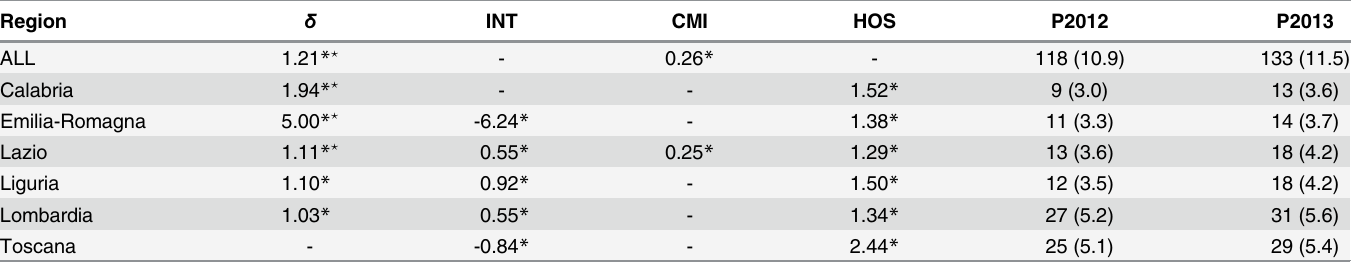
Table 11. Estimates and predicted claims due to injuries at birth. The asterisk indicates significance at 5% level, the star ? indicates that δ is also signifi- cantly different from 1 at the 5% level. In brackets, we provide the standard deviations of the predicted claims in 2012 (P2012) and 2013 (P2013). Region